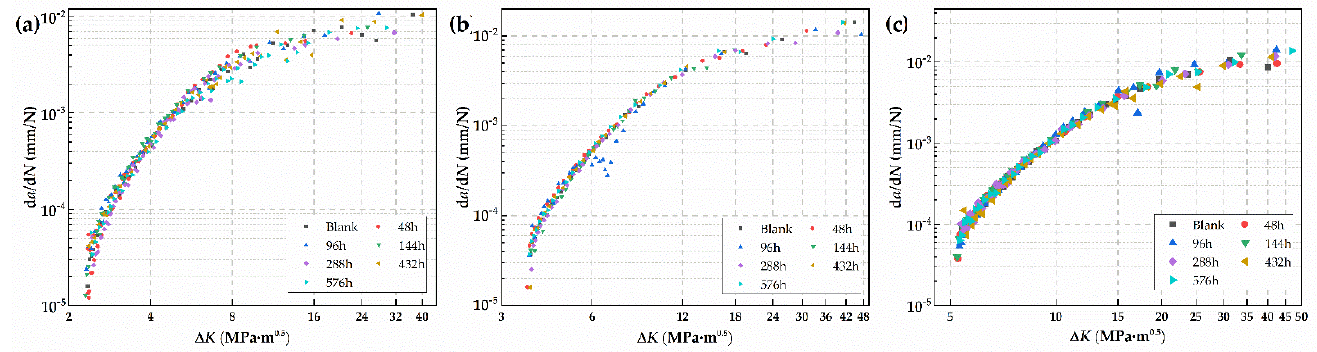
Figure 7. The curves of the fatigue crack propagating rate and the amplitude of stress intensity factor under mean stresses of ( a ) 5 MPa, ( b ) 7.5 MPa, and ( c ) 10 MPa.